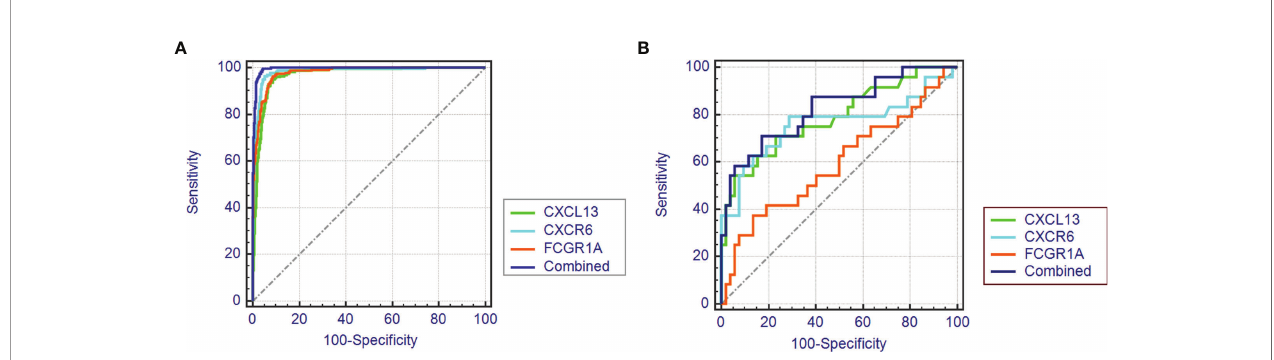
FIGURE 4 | The receiver operating characteristic (ROC) curve of the diagnostic effectiveness of the three diagnostic markers. (A) ROC curve of CXCR6, CXCL13 and FCGR1A in the metadata cohort. (B) ROC curve of CXCR6, CXCL13 and FCGR1A in the GSE69677